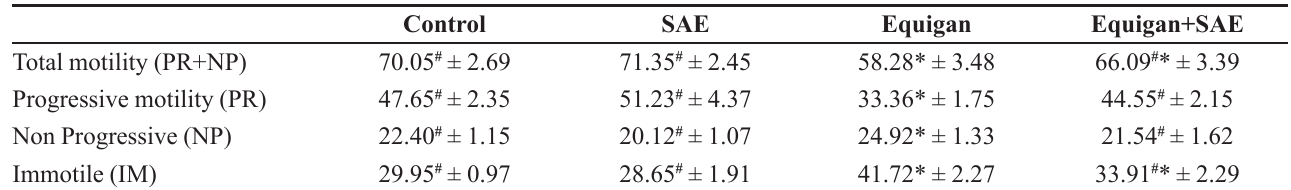
TABLE IV - Changes in the epididymal sperm total motility (PR+NP), progressive motility (PR), non-progressive (NP) and immotile (IM) (%) in the different groups under study